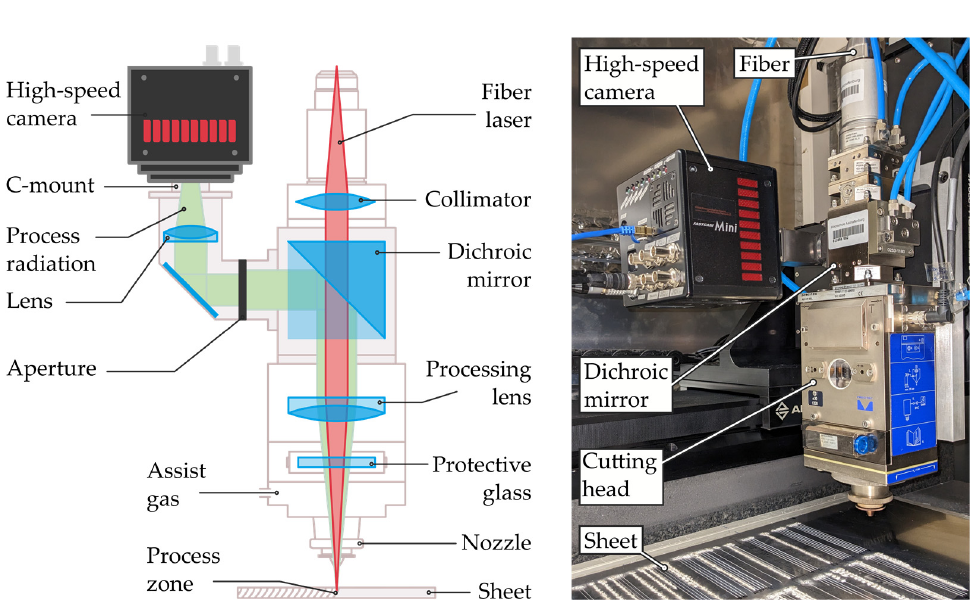
Figure 1. Schematic illustration with a photo of the setup of the monitoring system with the cut- ting head and the high-speed camera. head and the high-speed